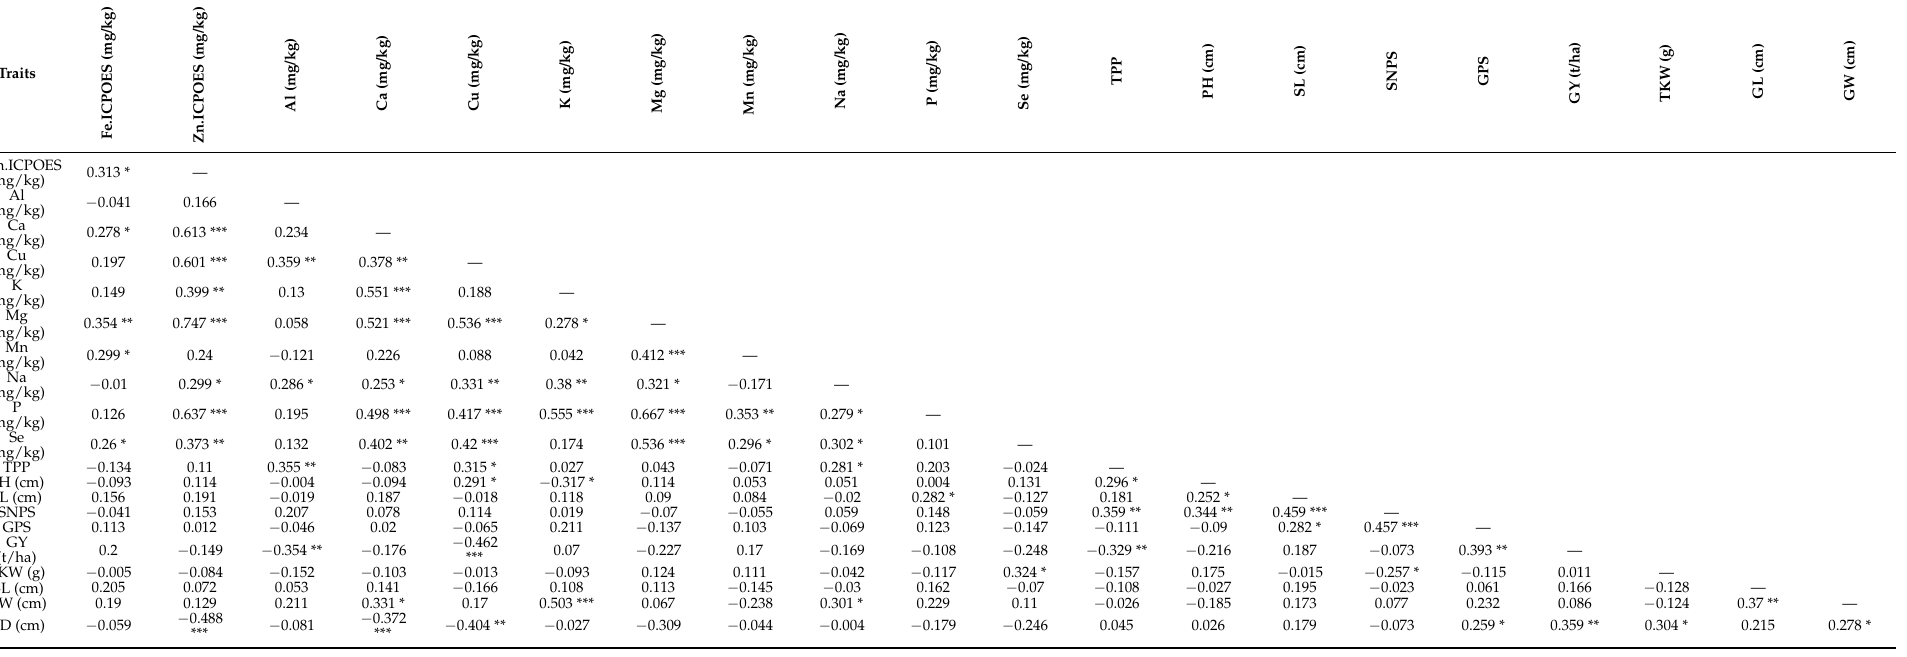
Table 4. Coefficient of correlation between morphological traits and grain micronutrients in historical wheat cultivars of